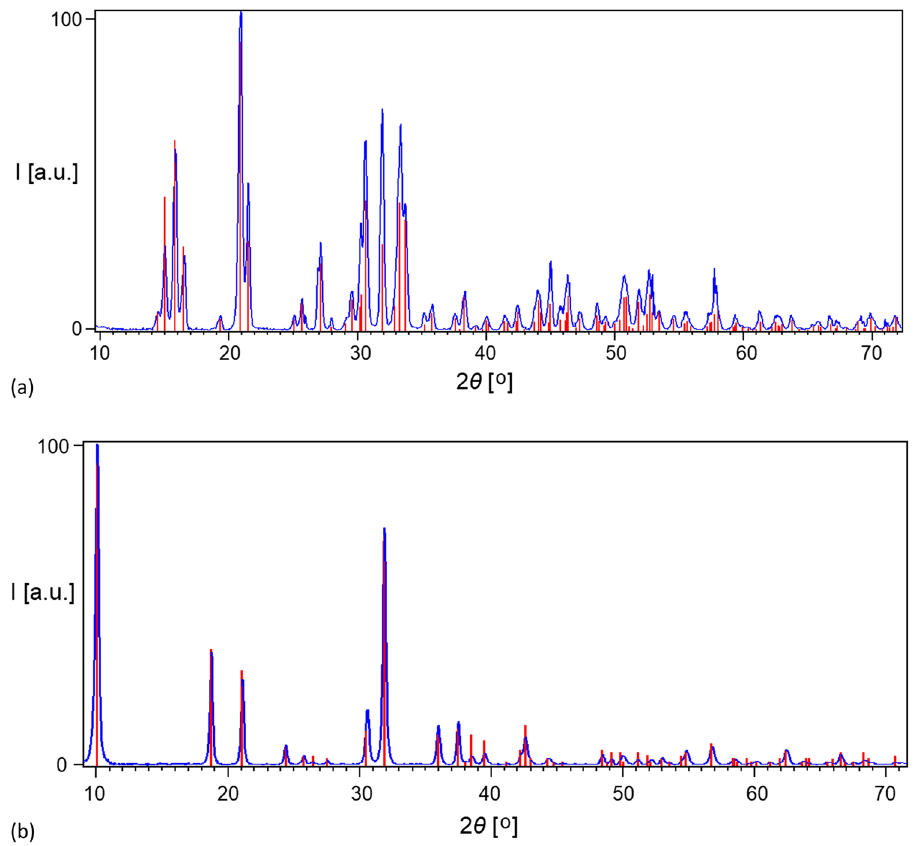
Figure 10. The XRPD pattern of struvite ( a ) before heating (blue), and struvite reference pattern (red) with PDF-2 code 01-071-2089, and ( b ) struvite heated (blue) in sealed crucible up to 393 K and dittmarite reference pattern (red) with PDF-2 code 00-036-1491.